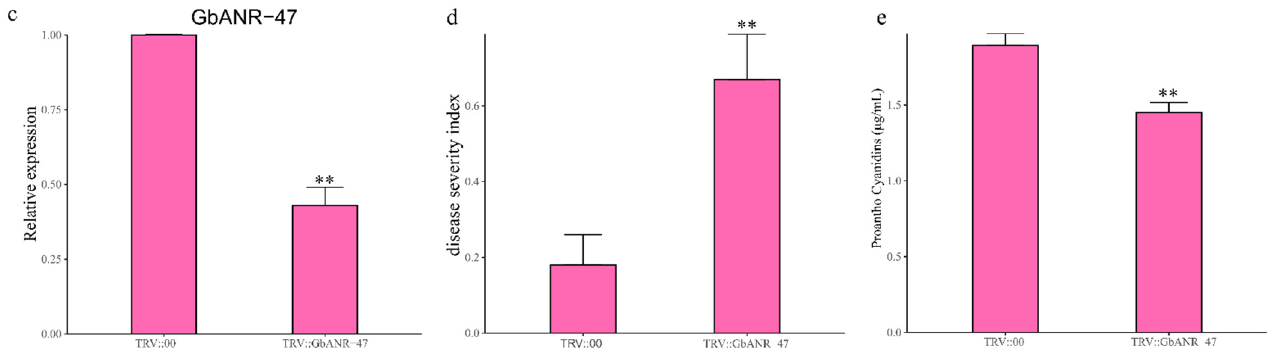
Figure 8. Effects of silencing Gb_ANR-47 on 06-146 susceptibility to FOV. Two weeks after infiltration, seedlings were inoculated with FOV. ( a ) Ten-day-old cotton plants were infiltrated with Agrobacterium carrying TRV:: GbCLA . Images were taken at 2 weeks after infiltration; ( b ) representative seedlings of control and silenced plants after inoculation with FOV at 21 days post-inoculation (dpi); ( c ) qRT–PCR results of silencing efficiency; ( d ) responses of control (TRV::00) and silenced (TRV:: Gb_ANR-47 ) plants to FOV at 21 dpi. DSI of control and silenced plants, each involving 15 experimental replicates. The DSI was measured at 21 dpi. ( e ) The error bars represent the standard deviations of 15 biological replicates; the asterisks indicate statistically significant differences, as determined by t tests (** p < 0.01).